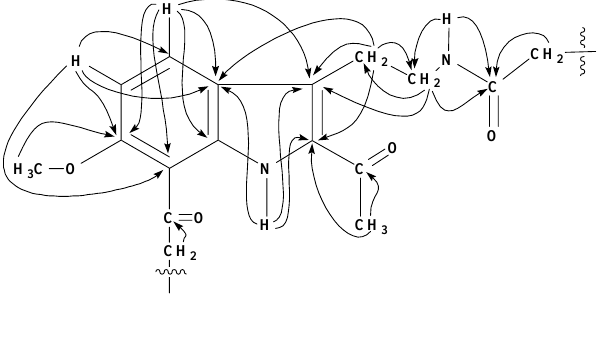
Figure 4. Significant HMBC ( 1 H (cid:198) 13 C) interactions of 8, N -diacyl analogues of tryptamine obtained from 1